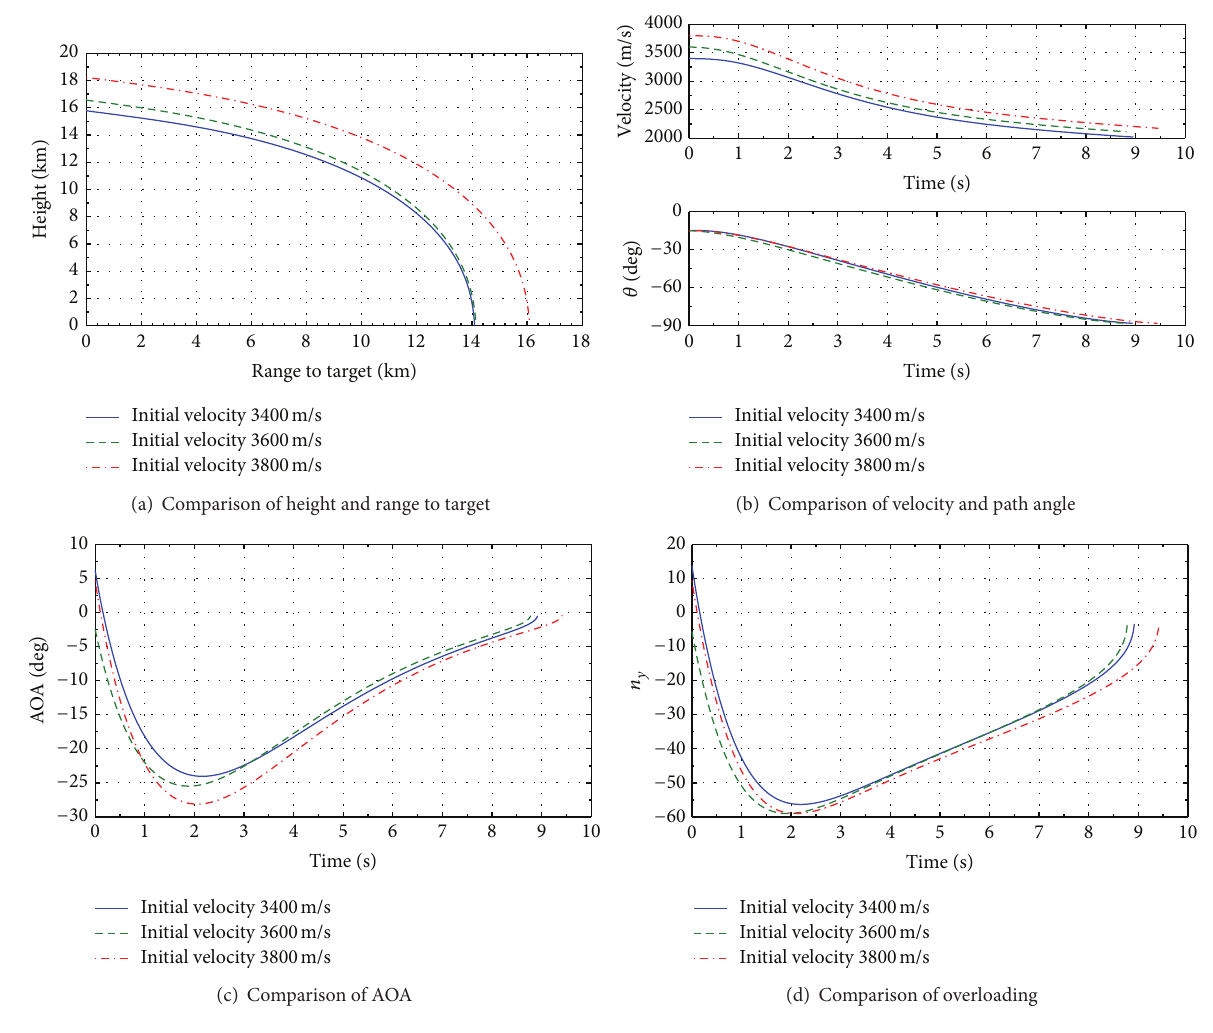
Figure 4: Comparison of flight characteristics with severe overloading